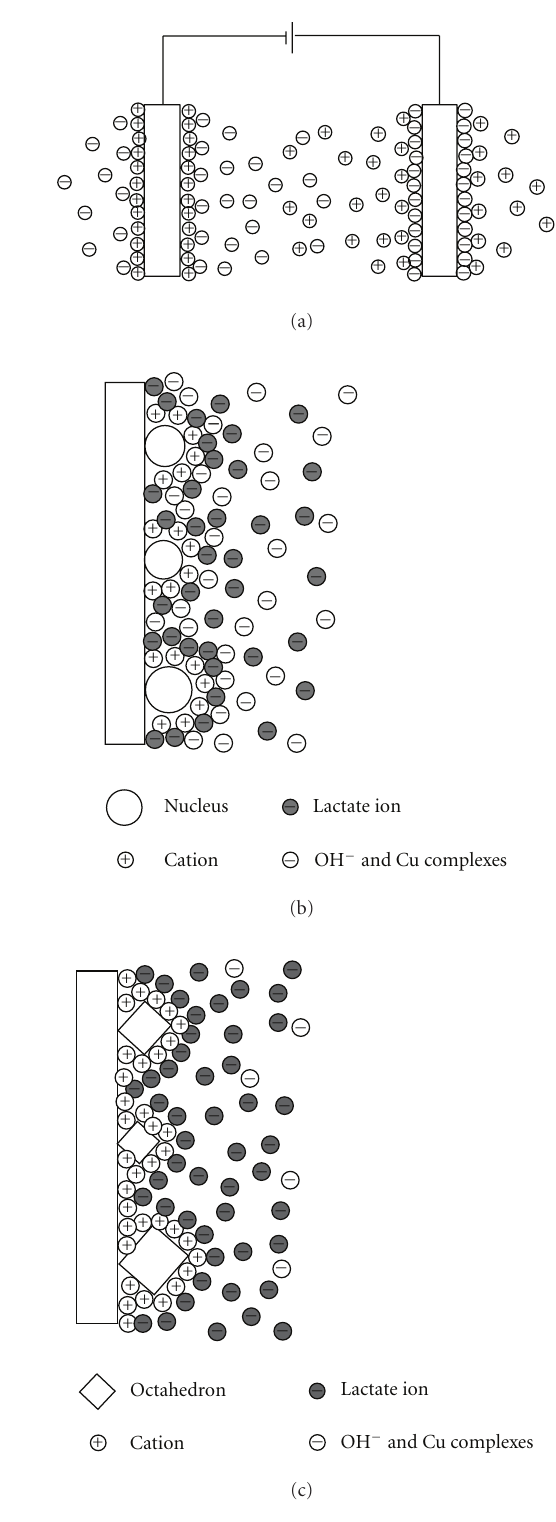
Figure 5: (a) Crystal structure of cubic-phase Cu 2 O; (b) and (c) schematic illustration of the crystal faces of Cu 2 O cube and octahe- dron.